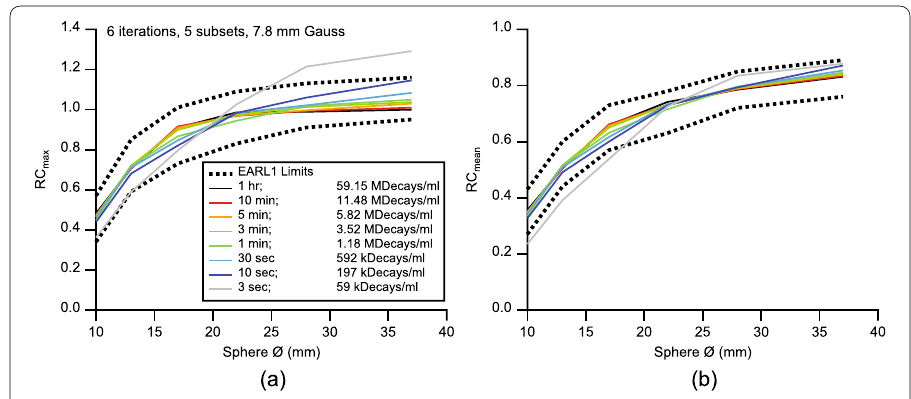
Fig. 3 Optimal EARL1 compliant RC max ( a ) and RC mean ( b ) recovery curves for different exposures resulting from 6 iterations, 5 subsets, and 7.8 mm Gauss FWHM. Legend applies to both